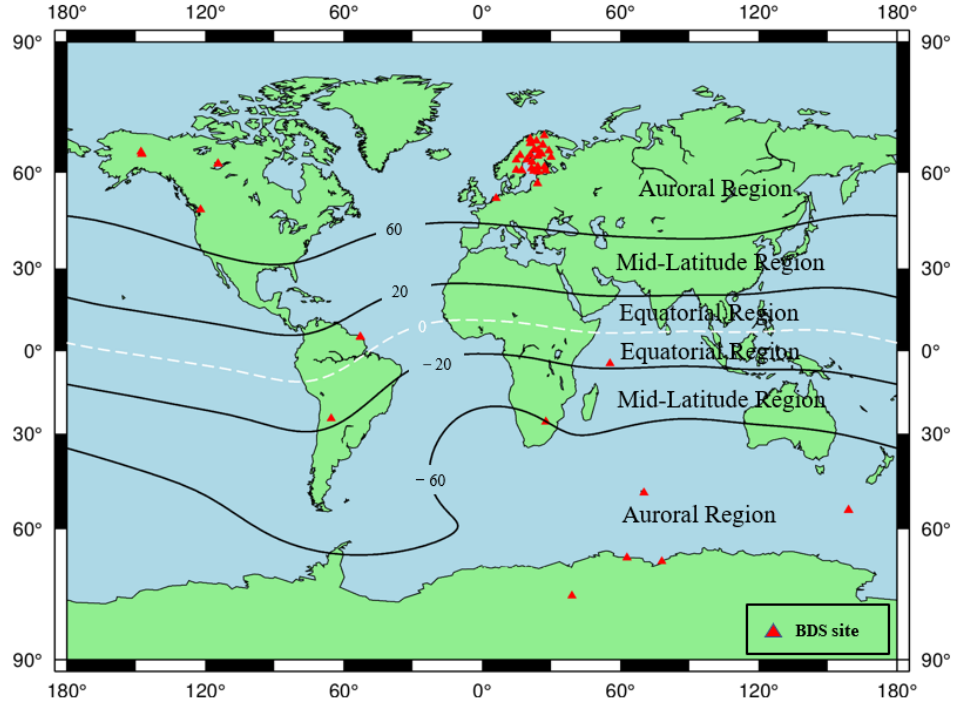
Figure 11. Spatial distribution map of BDS sites affected by the geomagnetic storm.